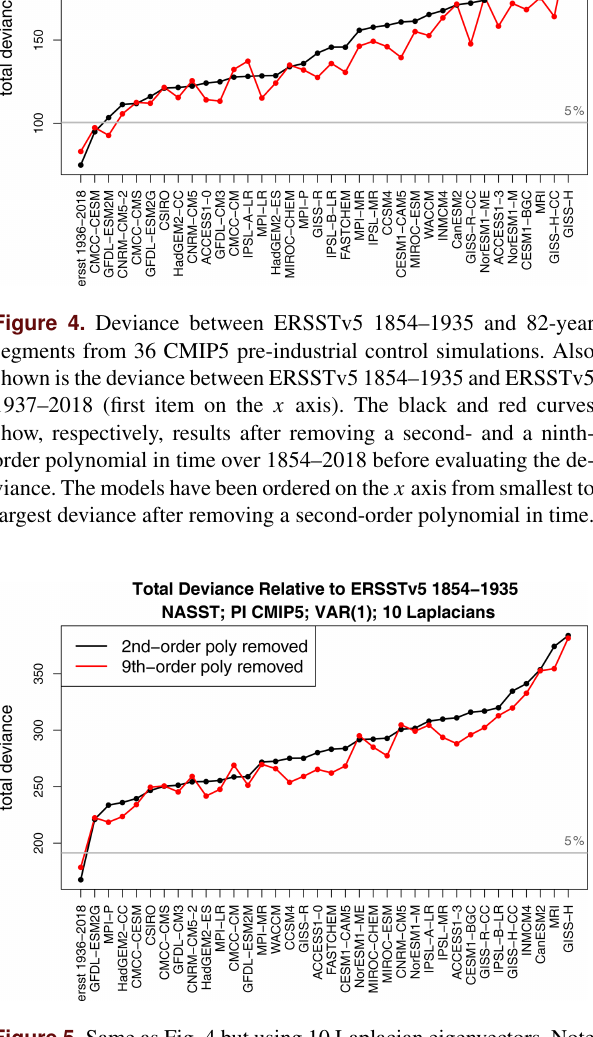
Figure 5. Same as Fig. 4 but using 10 Laplacian eigenvectors. Note that the order of the models on the x axis differs from those in Fig.